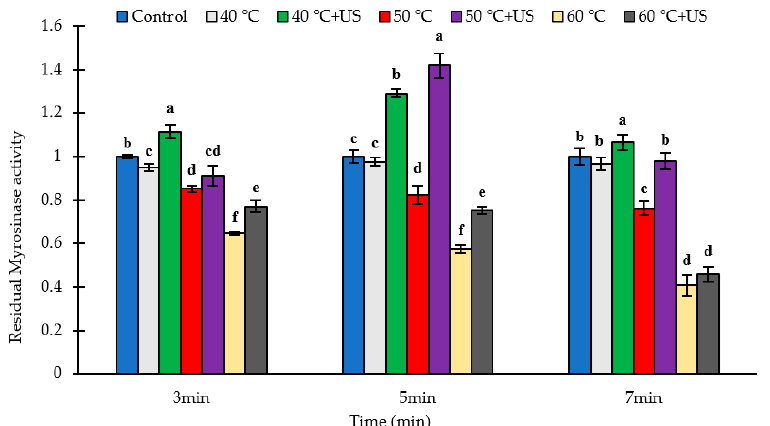
Figure 2. The residual activity of myrosinase in broccoli puree after thermal/thermosonication pre-treatments of broccoli floret. Letters above each bar indicate the results of Duncan’s test; Different letters within the same group indicate significant difference ( p < 0.05).